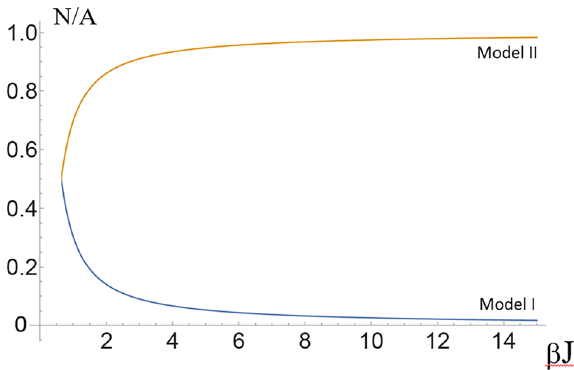
Figure 3. Plot of the lattice site occupation at which clustering begins as a function of the interaction energy J . When the concentration of cadherin is low (Model I), a uniform distribution of cadherin complexes can become unstable as the area of the membrane decreases and results in an increase in the concentration of cadherin. The phase transition that occurs in Model II (high cadherin concentration) is symmetrical to this first about N / A = 0.5 ; as the concentration of cadherin decreases, by increasing the area of the membrane, clusters begin to